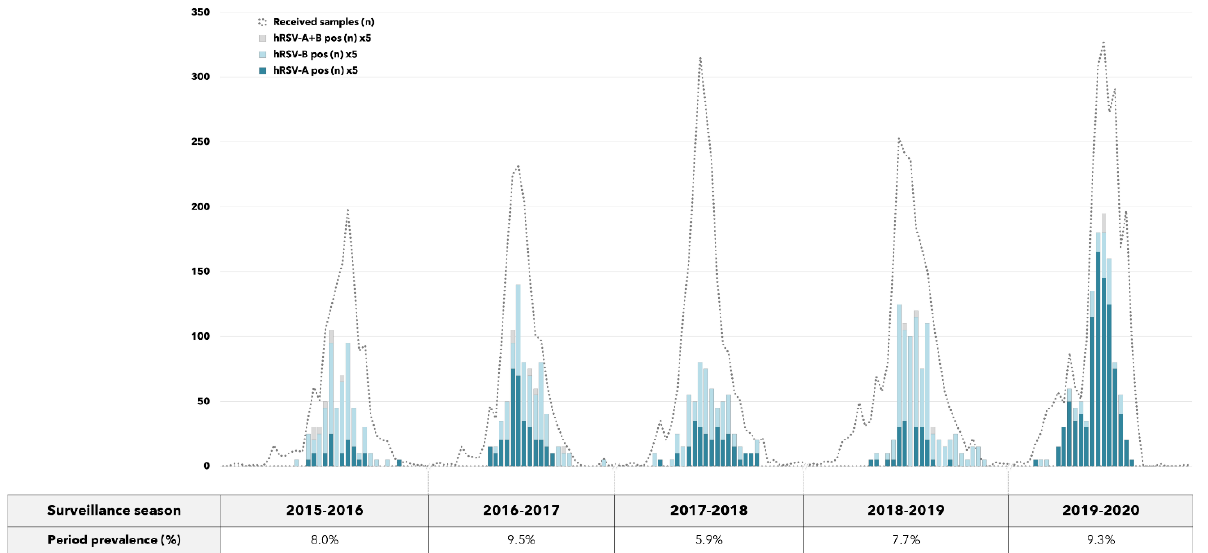
ARDS = Acute Respiratory Distress Syndrome. † Percentages are not mutually exclusive.